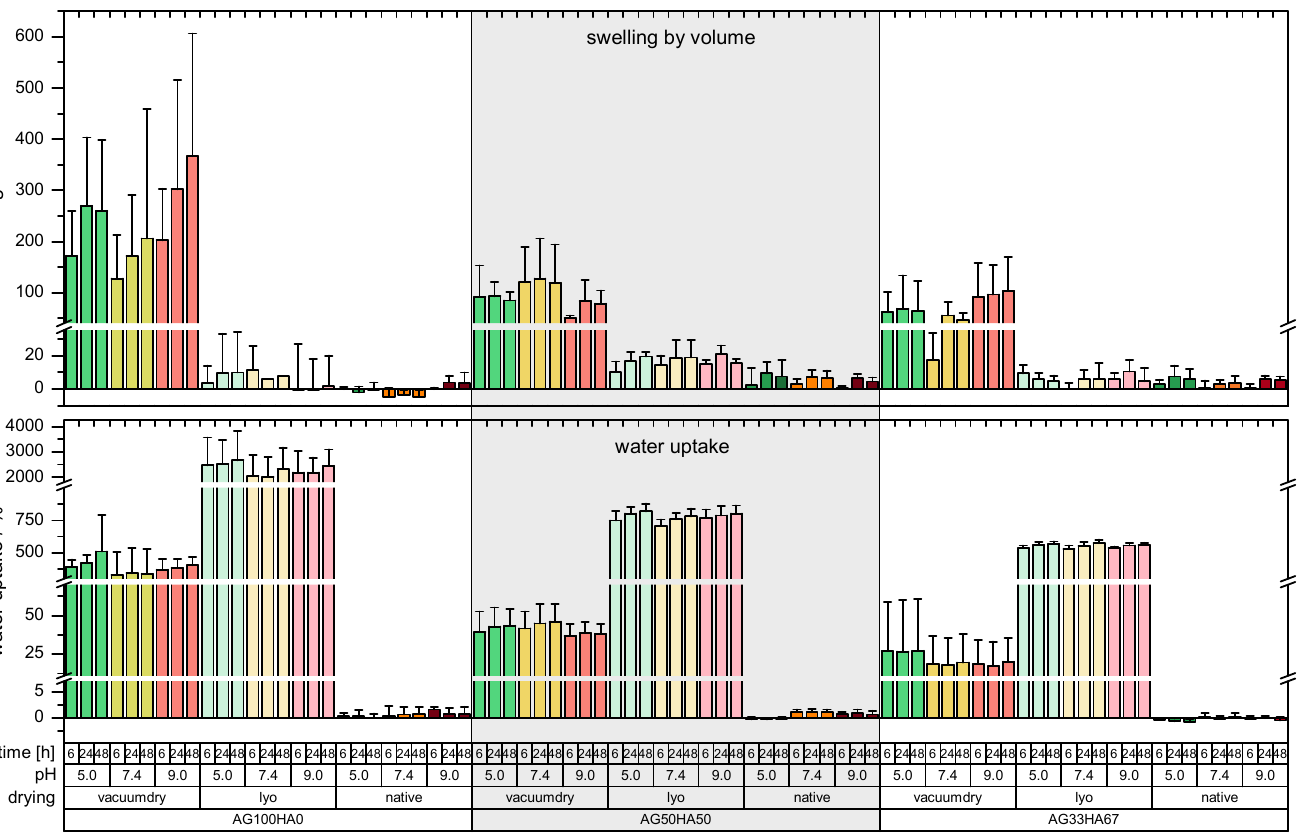
Figure A2. Complete dataset of swelling by volume and water uptake experiments. All three scaffolds were tested at different pH (5.0, 7.4, and 9.0) over 48h after different drying methods (vacuum drying, lyophilization, and as native